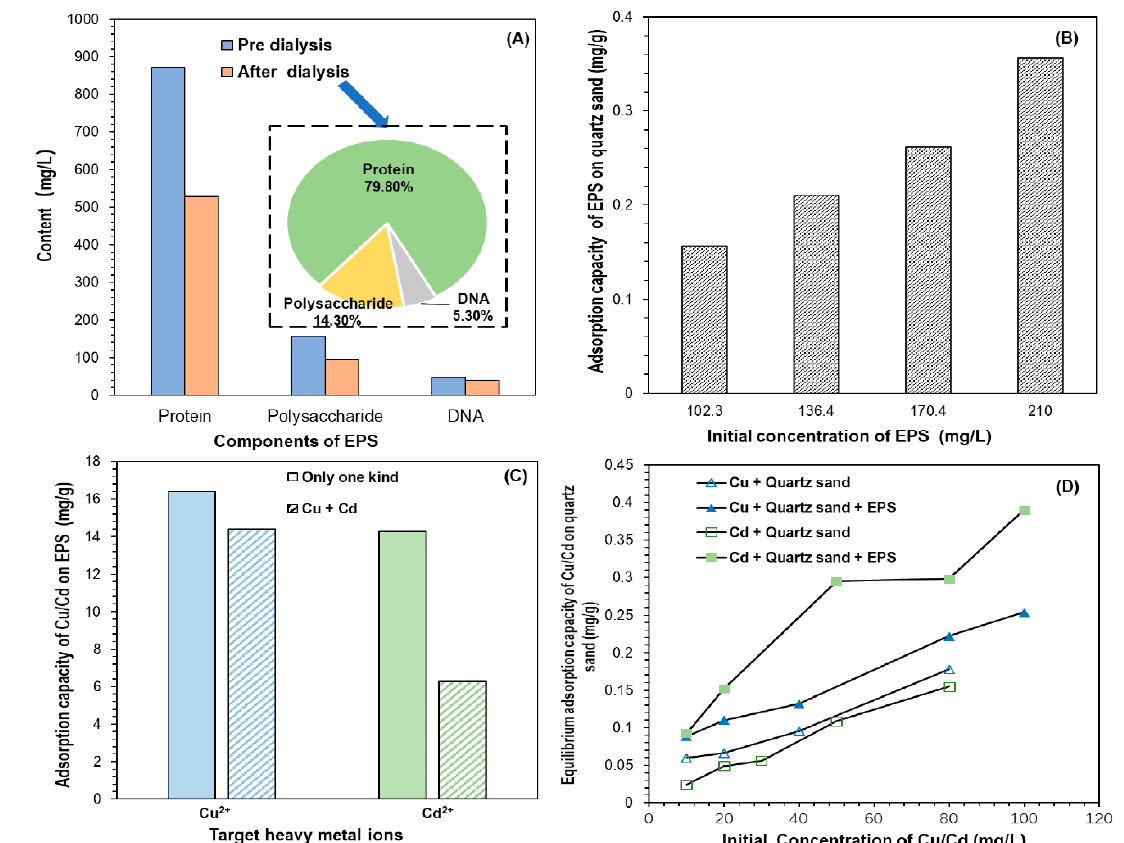
Figure 3. ( A ) Effect of dialysis on the content of EPS composition and the percentage of components of EPS after dialysis, ( B ) experimental results of adsorption (adsorption of different concentrations of EPS on quartz sand), ( C ) effect of coexisting ions on the adsorption of heavy metals by EPS, and ( D ) the influence of EPS on the adsorption of quartz sand with Cu 2+ and Cd 2+ .